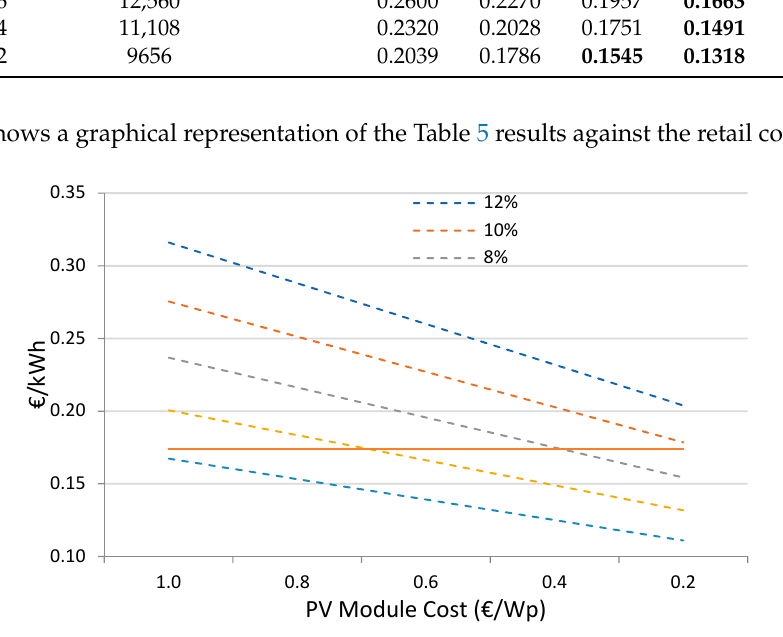
Figure 5. Analysis of the LCOE against the retail electricity cost at various interest rates (5000 W inverter, deterministic method).